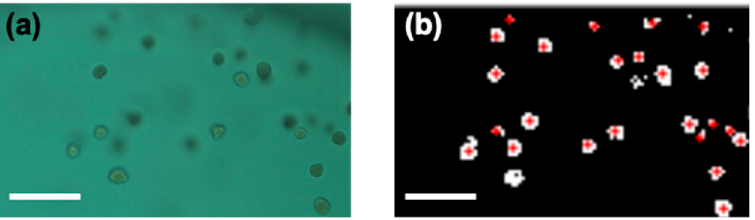
Figure 3. ( a ) RGB raw image from charge coupled device (CCD)camera. ( b ) Processed binary image with red crosses indicating the bacterial colonies.